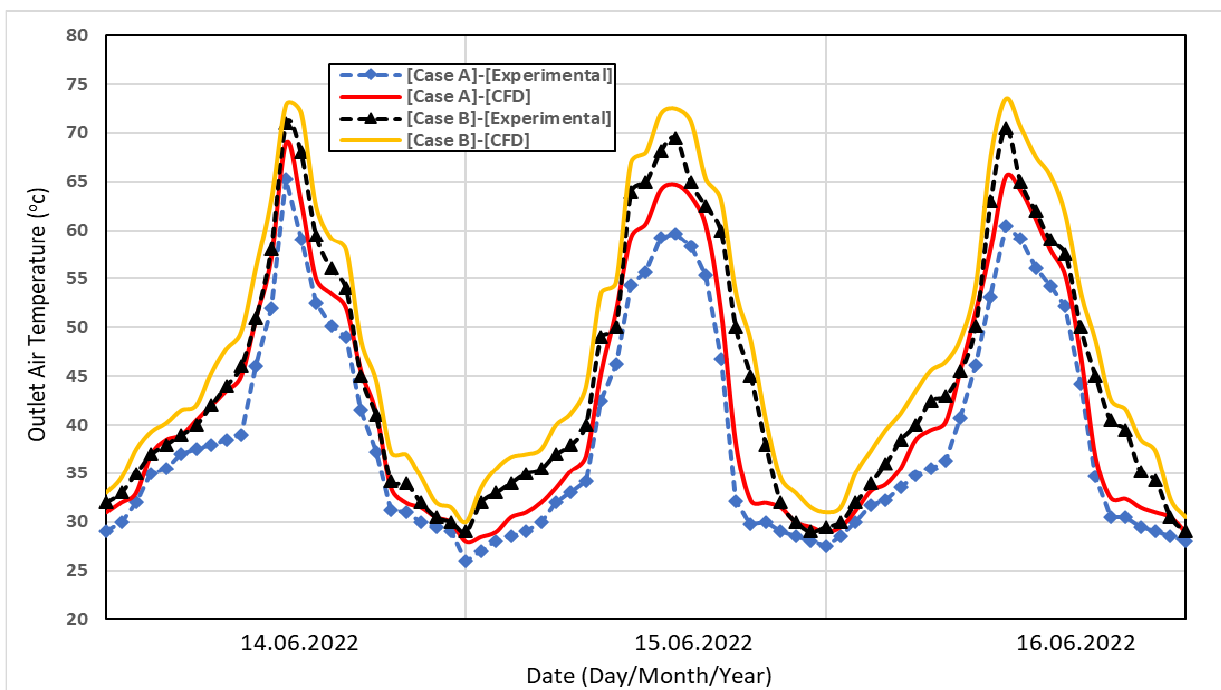
Figure 12. Validation in the CFD outlet airflow temperature variation and the experimental data for the two tested FPSAHs.